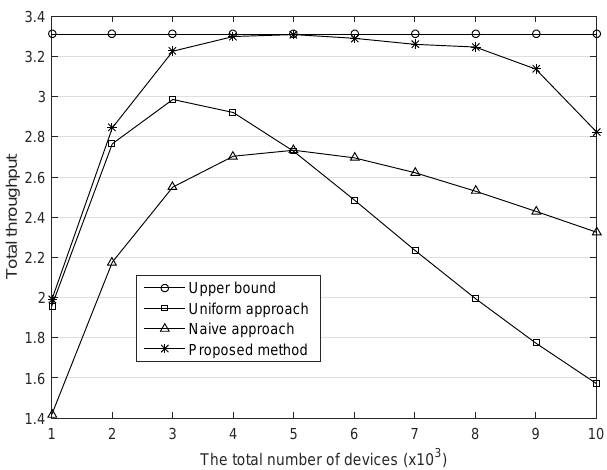
Figure 8. The comparison of the total throughput. The upper bounds of ratio of smallest SF { 0.8,0.1,0.1 }